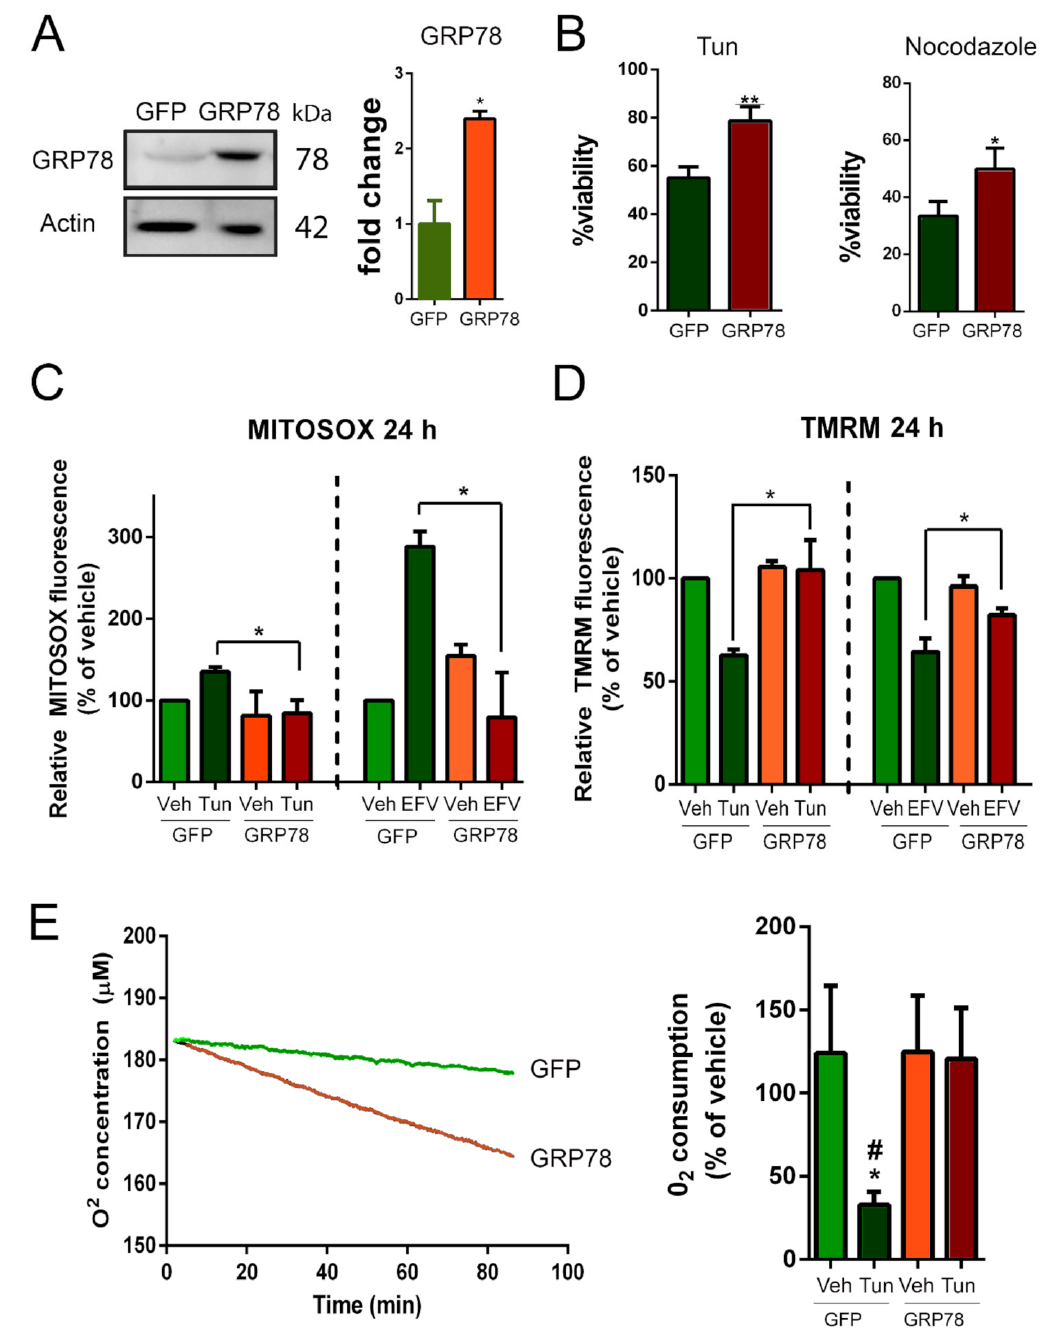
Figure 3. GRP78 overexpression rescues mitochondrial dysfunction in stressed NSC34 cells. ( A ) Immunoblot and bar graph showing the levels of GRP78 in NSC34 cells nucleofected with plasmid vector to overexpress GRP78 or a non-related protein as control (GFP). ( B ) Percentage of survival of GFP- or GRP78-expressing NSC34 cells (means ± SEM) after 24 h in medium containing 1 µ g/mL tunicamycin (Tun) (left) or 10 µ M nocodazole (right) determined using an MTT assay ( n = 4; * p < 0.005, ** p < 0.001 vs. GFP, Student’s t -test). ( C ) Quantitative analysis of MitoSOX fluorescence in cells overexpressing GFP or GRP78 and treated with Tun or vehicle (left) or efavirenz (EFV) as control or vehicle (right). ( D ) Quantitative analysis of TMRM fluorescence in cells overexpressing GFP or GRP78 and treated with Tun or vehicle (left) or EFV or vehicle (right) (GFP-Veh is the control group). ( E ) Left: Representative analysis of O2 concentration (using a Clark-type O2 electrode) as a function of time in cells overexpressing GFP or GRP78 and treated with Tun. Right: O2 consumptions after 5 h of Tun treatment in cells overexpressing GFP or GRP78 (GFP-Veh is the control group) ( n = 4; * p < 0.05 vs. Veh-GFP, # p < 0.05 vs. GRP78, one-way